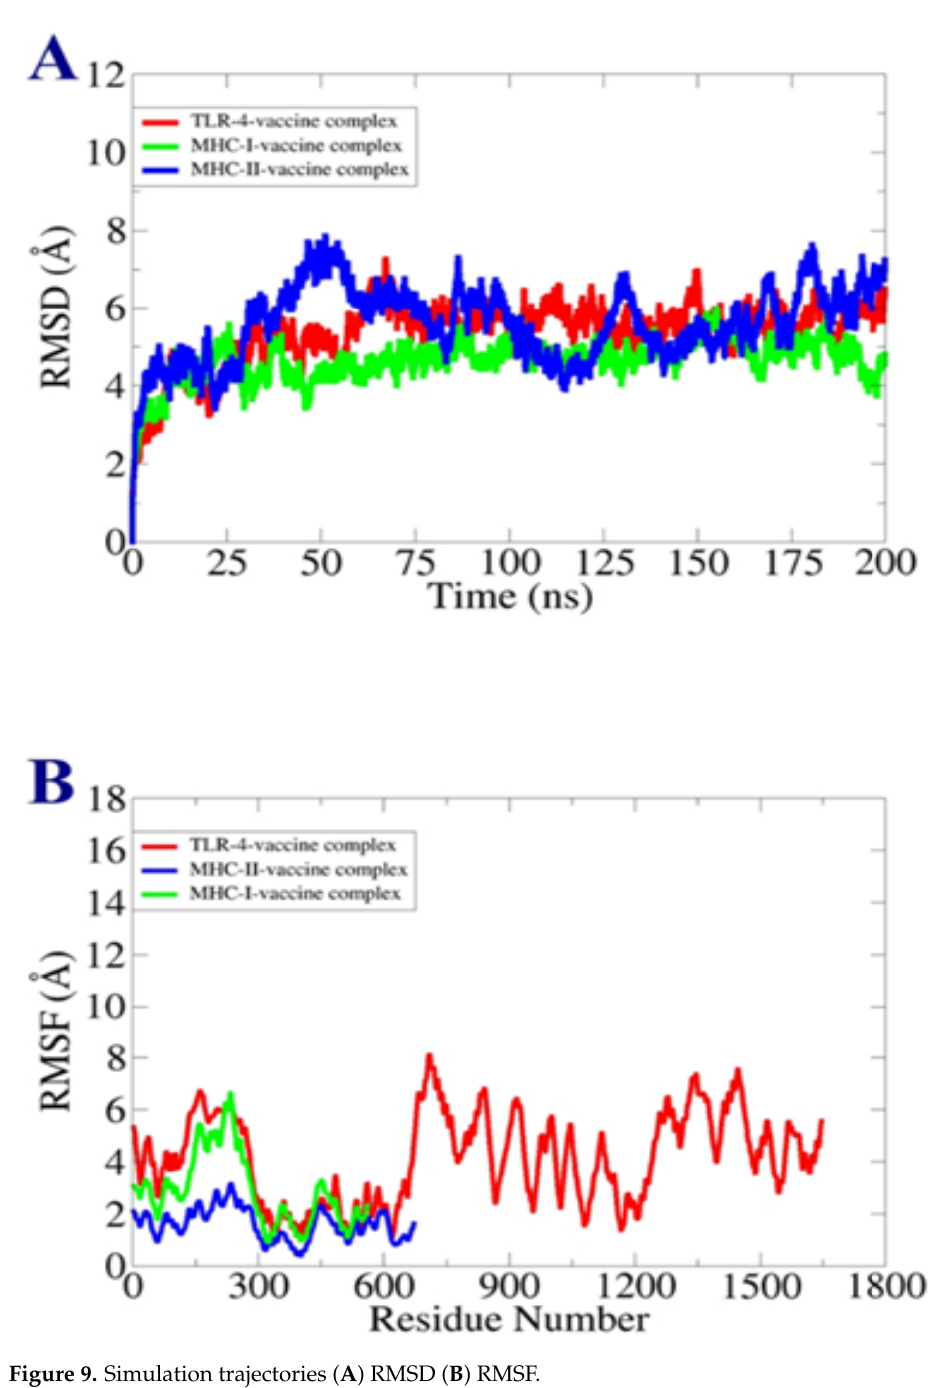
Figure 9. Simulation trajectories ( A ) RMSD ( B )